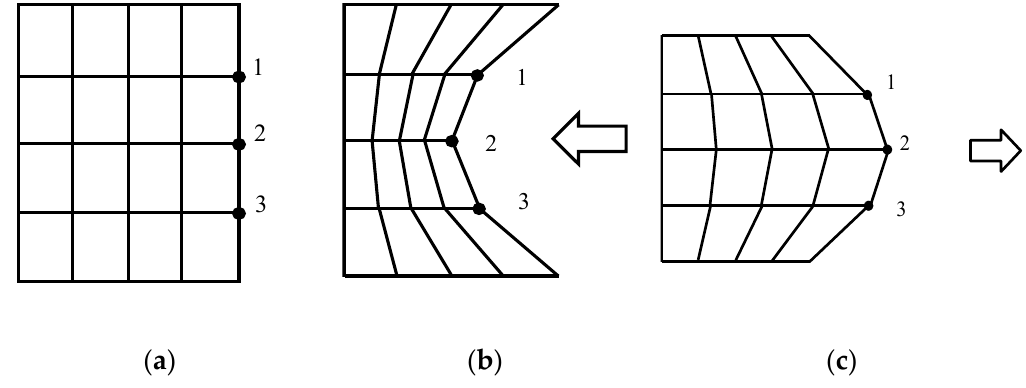
Figure 16. Remeshing problem of analysis model, ( a ) w i = 0, ( b ) w i = 1, ( c ) w i = −